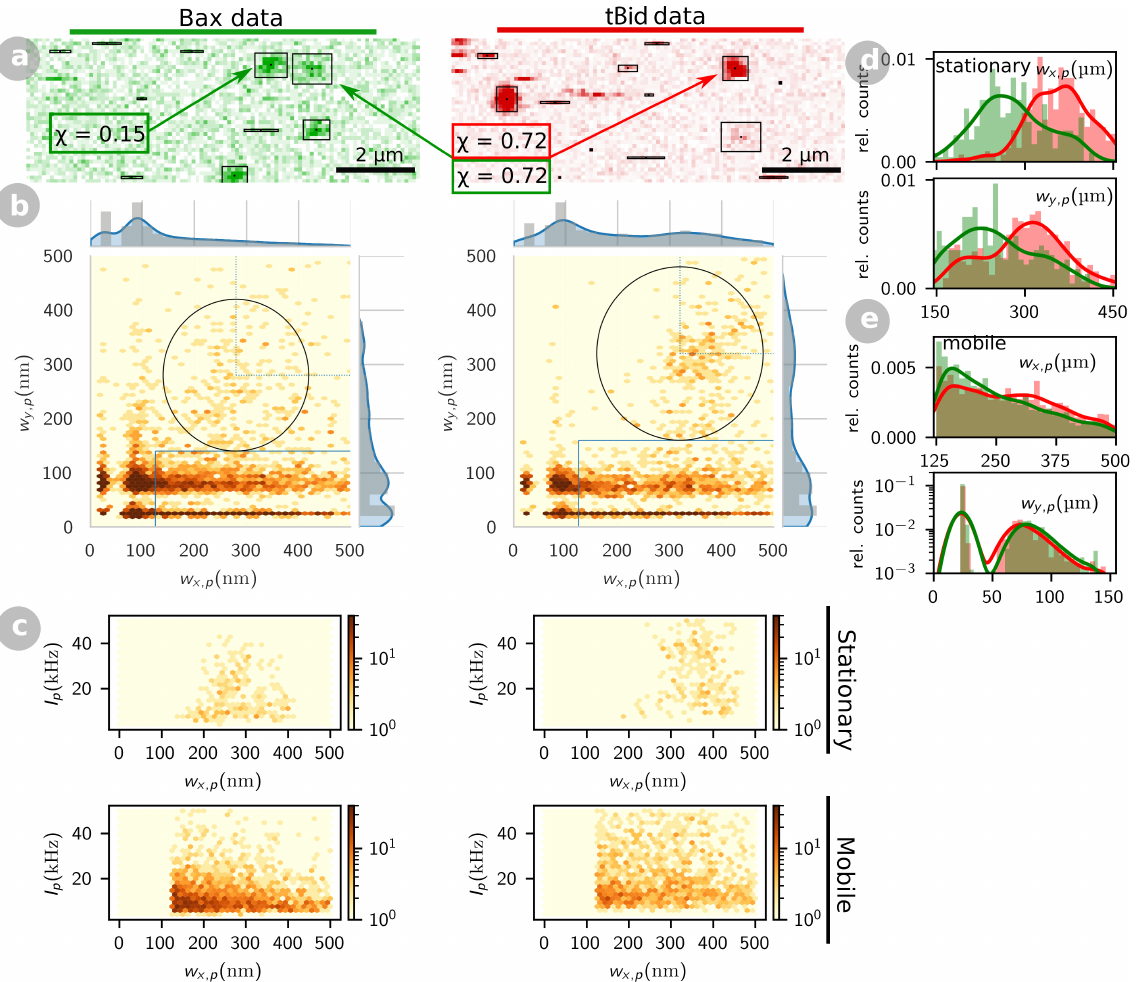
Figure 3. Event detection for confocal images of SLB incubated with tBid-Alexa647 and Bax-HyLite488. ( a ) Representative example of a section of a pair of confocal images (left: green detection channel, right: red detection channel) acquired for a SLB incubated successively with 0.2nM tBid-Alexa647 and 1.0nM Bax-HyLite488. Black boxes highlight all the events detected in these images. ( b ) Eccentricity maps and ( c ) intensity maps obtained for the entire set of 258 images acquired (regardless of Bax concentration). Solid lines delimitate the regions used to classify the particles as stationary or mobile, considering w 0 = 280nm (green channel) or w 0 = 320nm (red channel). The distributions of observed w x , p and w y , p values are given in ( d ) for stationary particles and in ( e ) for mobile particles (green lines and bars: Bax, red lines and bars: